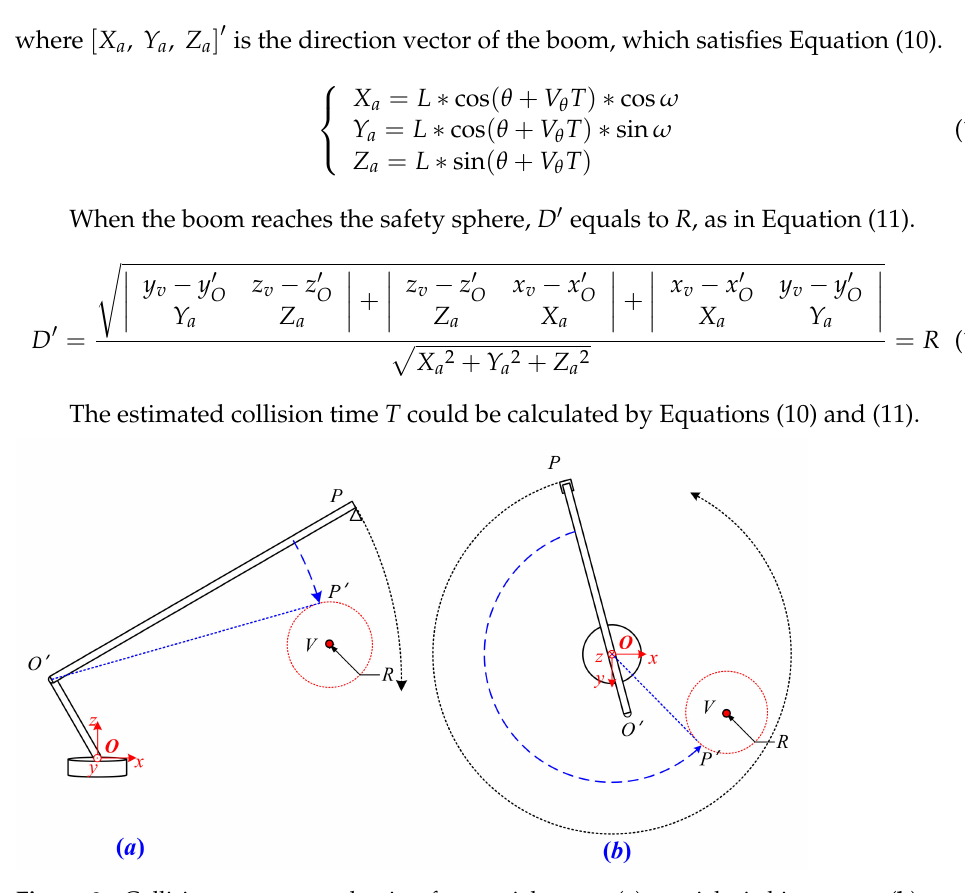
Figure 9. Collision urgency evaluation for special cases: ( a ) special pitching cases, ( b ) special rotating